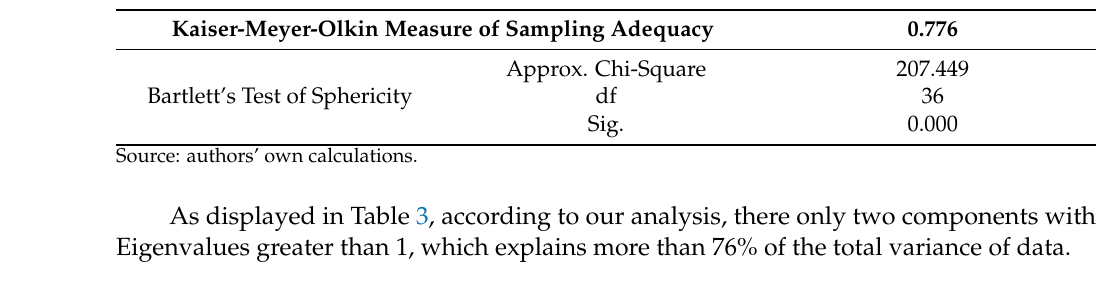
Table 2. KMO and Bartlett’s Test—digitalization